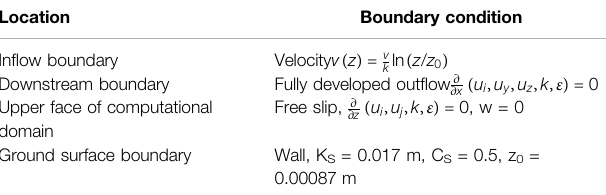
TABLE 2 | Computational domain boundary conditions. Location